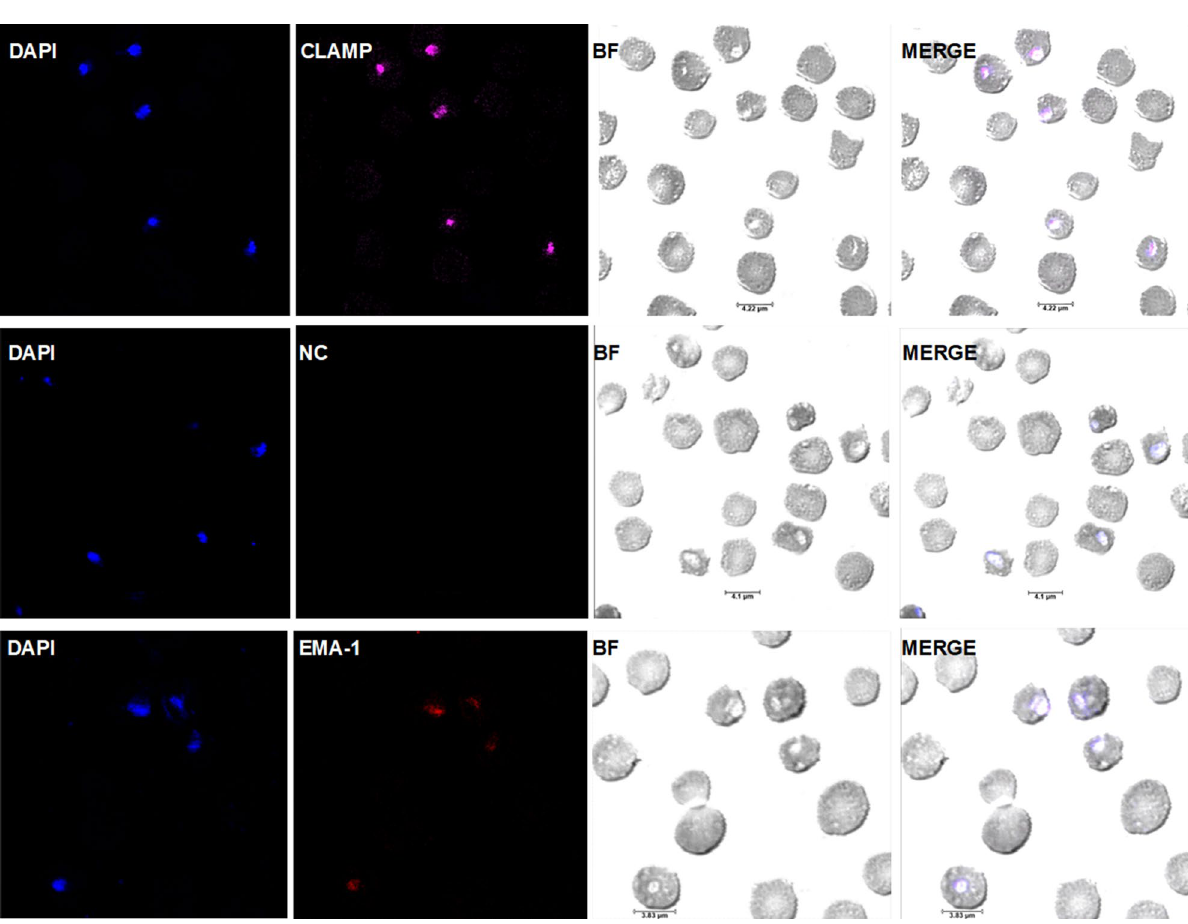
Figure 3. CLAMP is expressed in the intra-erythrocytic stages of T. equi development. Confocal microscopy images showing expression of CLAMP in T. equi infected erythrocytes. The first row shows expression of CLAMP by T. equi gamonts. Parasite nuclei are stained in blue with DAPI, and CLAMP is stained in magenta. The second row shows infected erythrocytes incubated with pre-immunization serum (negative control) and it shows lack of staining indicating test specificity. The third row indicates expression of EMA-1 (positive control (PC)) by intra-erythrocytic parasites. In all cases, BF refers to brightfield The indirect immunofluorescence antibody tests further suggests that translocation of CLAMP occurs from the micronemes to the cell surface in extracellular merozoites, and its expression is maintained in the intra-eryth- rocytic developmental stages. This indicates functional significance of the protein in the parasite. A significant role of T. equi CLAMP in invasion of equine erythrocytes was demonstrated by the in vitro neutralization assay, which showed that CLAMP-specific antibodies significantly inhibit cellular invasion by merozoites. This find- ing also suggests that the antibodies developed against CLAMP in vivo could also have a neutralizing capacity against T. equi , thus reinforcing the fact that the protein is a viable vaccine candidate and future studies should be focused on testing its potential in vivo. Investigation of erythrocyte proteins that interact with CLAMP presumably during invasion and establish- ment of T. equi within the cell led to the isolation and identification of key components of the erythrocyte membrane skeleton that form a complex network in the inner membrane of the cell 16 . These proteins maintain the structure, shape, durability, stability, and plasticity of the cell membrane 16,17 . Crosslinking of CLAMP to extracellular erythrocytic proteins led to isolation of the α- and β-spectrin proteins and crosslinking of the protein to intramembrane and intracellular erythrocytic proteins led to the isolation of the spectrin proteins alongside the anion-exchange protein, band 4.1, cytoplasmic actin 1 and tropomyosin 3. A model emerging from the interpretation of these findings suggest that T. equi merozoites use CLAMP to attach to the α- and β-spectrin proteins in the initial stages of invasion, possibly during the formation of a tight junction between the parasite and the host cell. Once inside the cell, the parasites maintain their association with the spectrin proteins while also interacting with the anion-exchange protein, band 4.1, cytoplasmic actin 1 and tropomyosin 3 (Fig. 7). This observation indicates that like most apicomplexan species, the early stages of T. equi invasion is possibly characterized by attachment and re-orientation of the parasite such that the anterior end is in direct apposition with the host cell 6,7 . This enables CLAMP to interact with the spectrin proteins in the inner cell membrane and these interactions are maintained post-invasion (Fig. 7). This suggests that T. equi micronemes are involved in the invasion of equine erythrocytes thus implying that the parasites utilize a mechanism that is